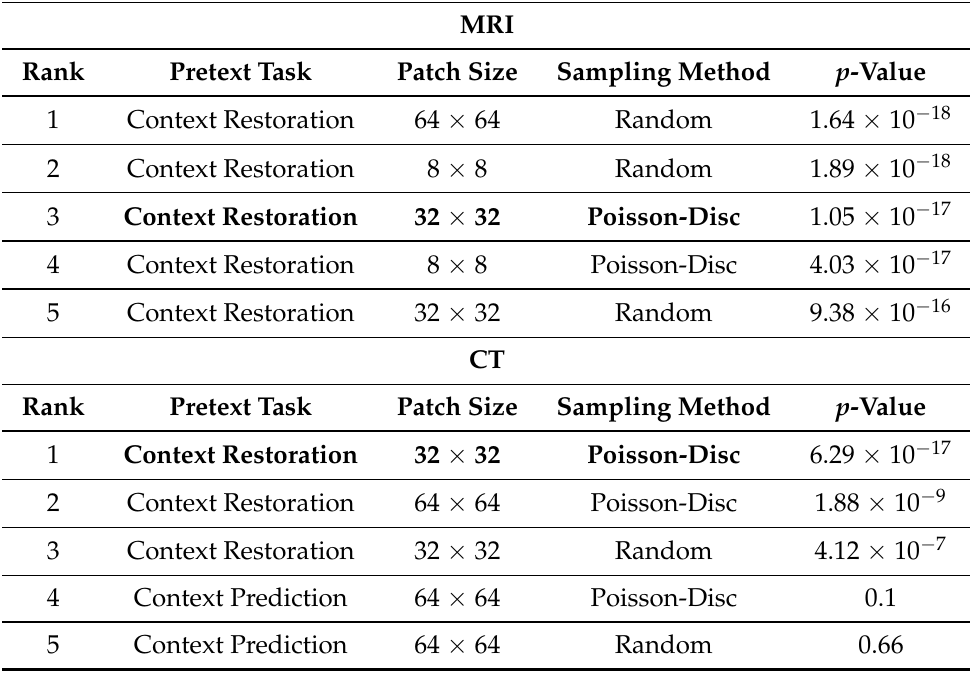
Table 3. Summary of the top five combinations of pretext tasks, patch sizes, and sampling methods for each dataset with the corresponding p -value for each combination, and sorted by p -value in ascending order. The bolded pretext task, patch size, and sampling method were chosen as the best combination of the three design